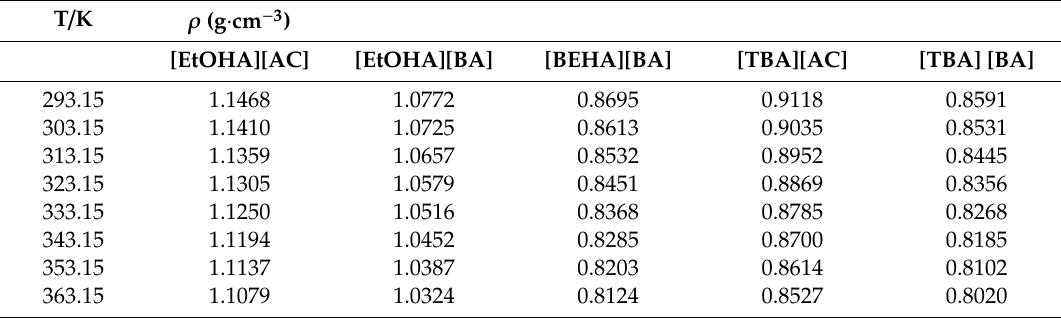
Table 2. Density ( ρ ) values of ionic liquids from 293.15 K to 363.15 K.